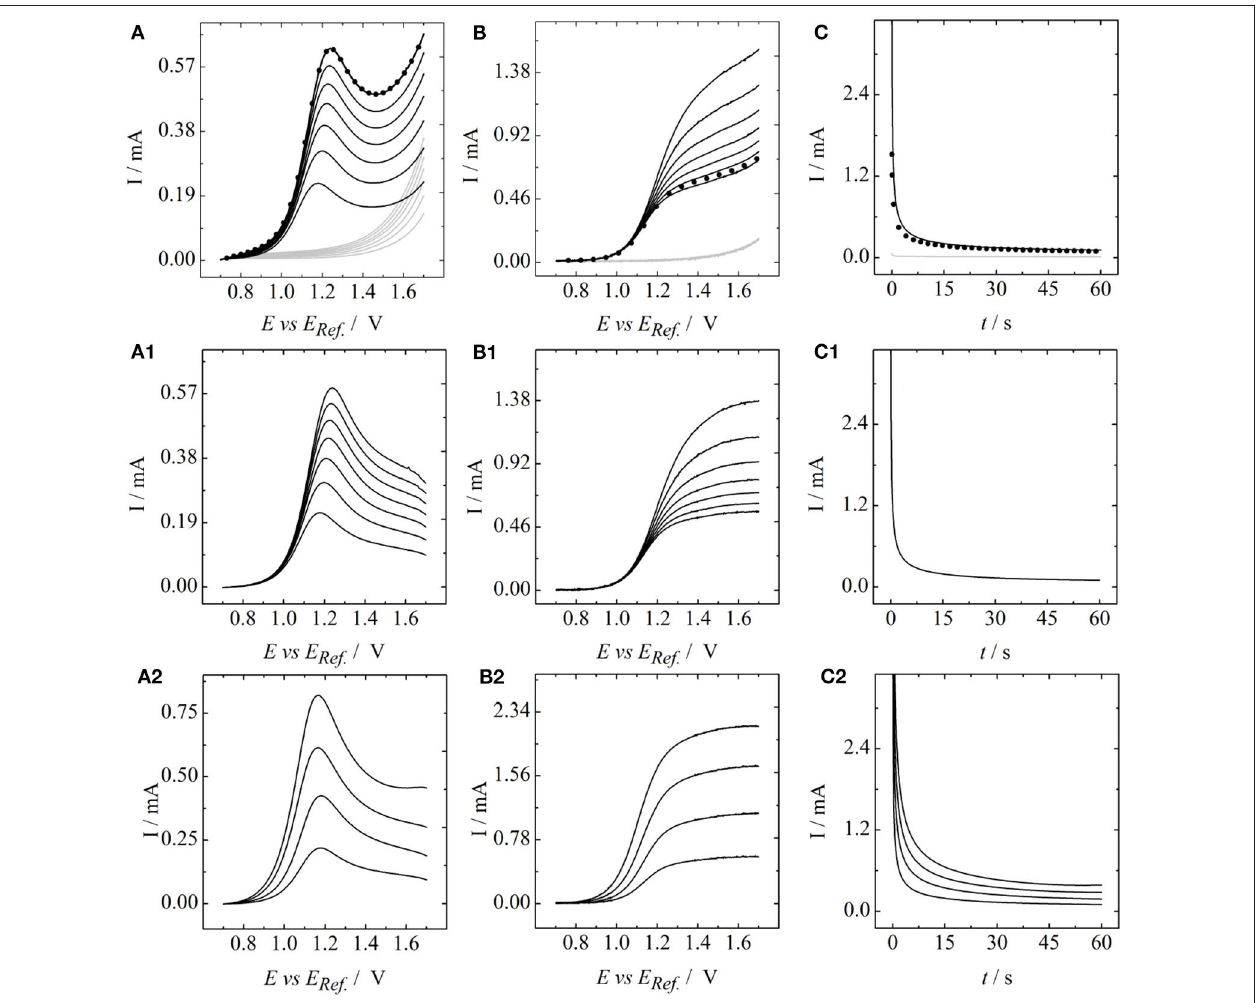
FIGURE 1 | (A) Stationary and (B) rotating linear sweep as well as (C) chronoamperometric measurements at a glassy carbon surface. Gray lines: 2 M sulfuric acid as a baseline, black lines: vanadyl sulfate containing 2 M sulfuric acid, black dots: repetition of initial measurements to check experimental reproducibility. (A1–C1) Represent baseline corrected data at a VO 2 + concentration of 0.02 M for (A1) varying scanrates and (B1) varying rotation rates. (A2–C2) Represent baseline corrected data for varying concentrations of VO 2 + at (A2) : a fixed scanrate of 10 mV/s and (B2) : a fixed rotation rate of 100 rpm. Potentials were referred to a saturated Ag/AgCl reference.